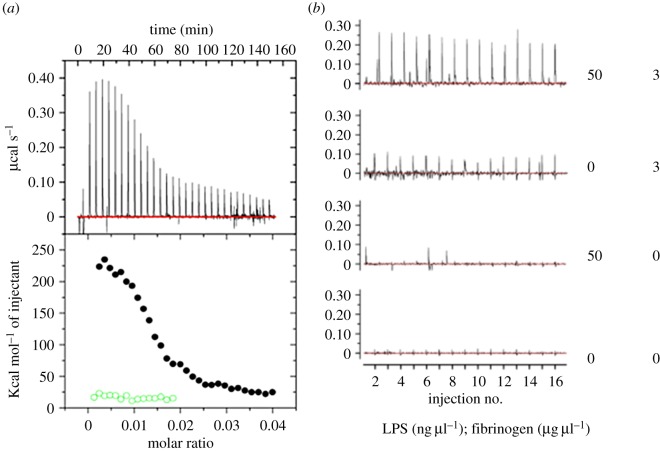
ITC analysis of the LPS–fibrinogen interaction. (a) Titration of 8.8 μM human plasma fibrinogen (black circles) or buffer (green open circles) into 100 µM of E. coli O111:B4 LPS. (b) Titration of 50 ng µl−1 LPS (2.5 µM) or buffer into 3 µg µl−1 fibrinogen (8.8 µM) or buffer as indicated. Experiments were conducted at 37°C in phosphate buffered saline. (Online version in colour.)